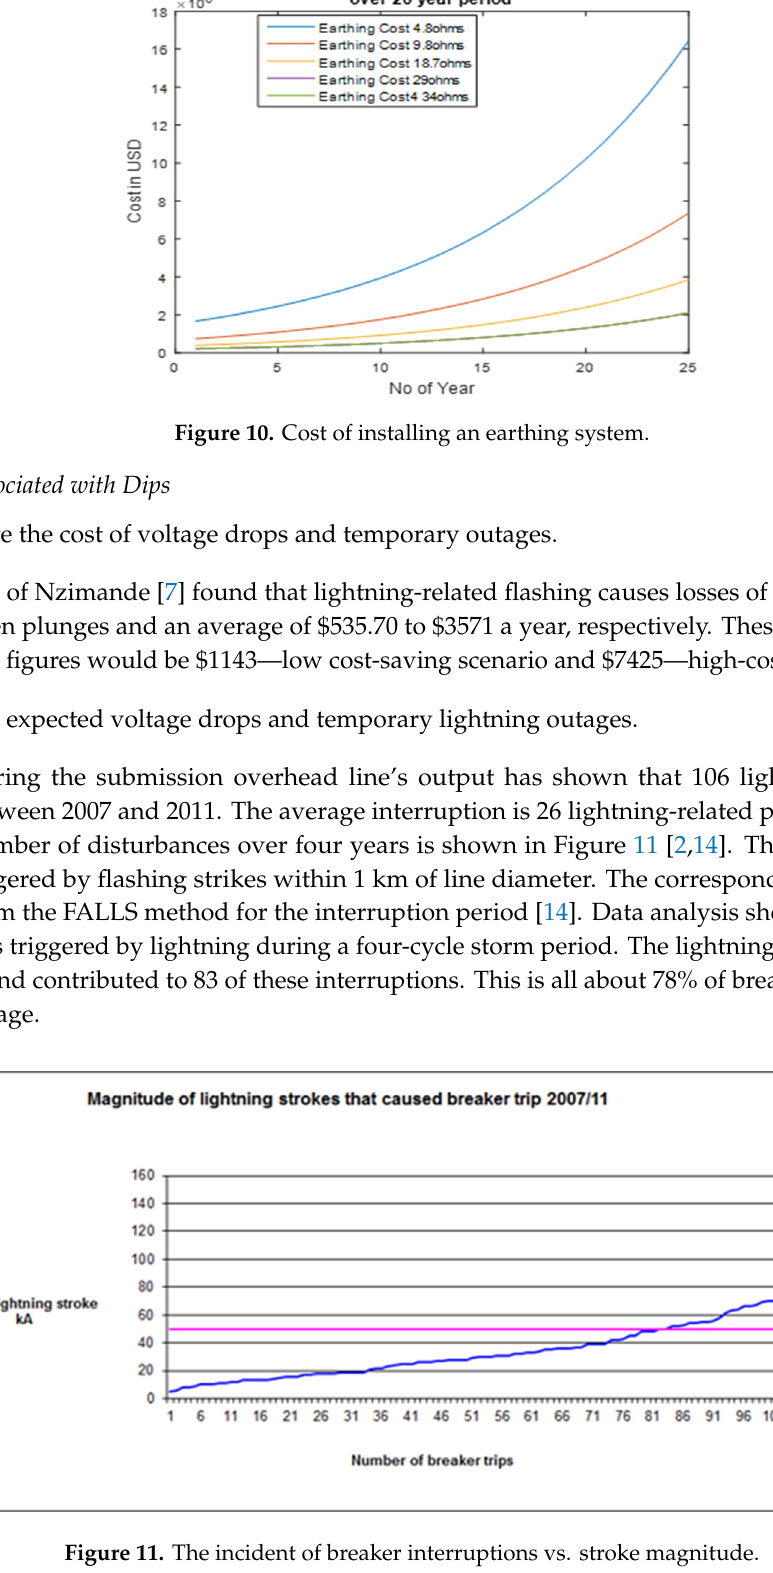
Figure 11. The incident of breaker interruptions vs. stroke magnitude.